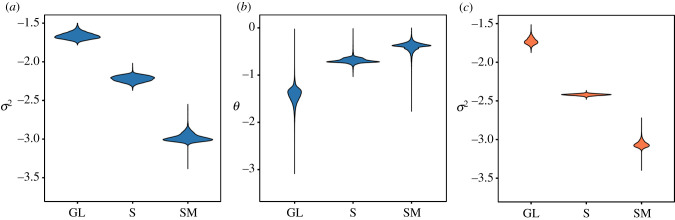
Evolutionary model parameters. Results from 10 000 simulations using the OUwie package of R. Sigma-squared (σ2), nondirectional rate of evolution; theta (θ), trait optima. (a,b) Parameters estimated under OUMV model of evolution; (c) parameter estimated under BMS model of evolution. GL, group-living; S, solitary; SM, social monogamy. (Online version in colour.)